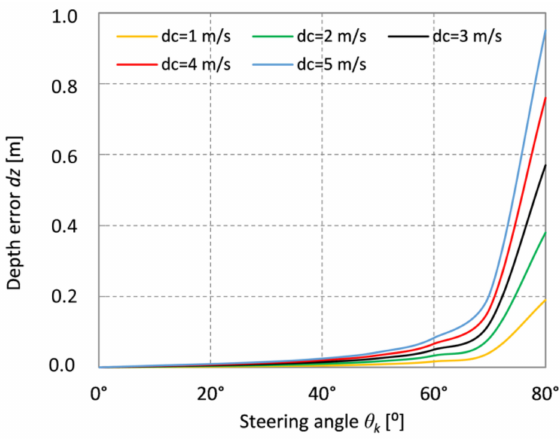
Figure 4. The impact of inaccurate surface sound velocity on the accuracy of depth measurement.